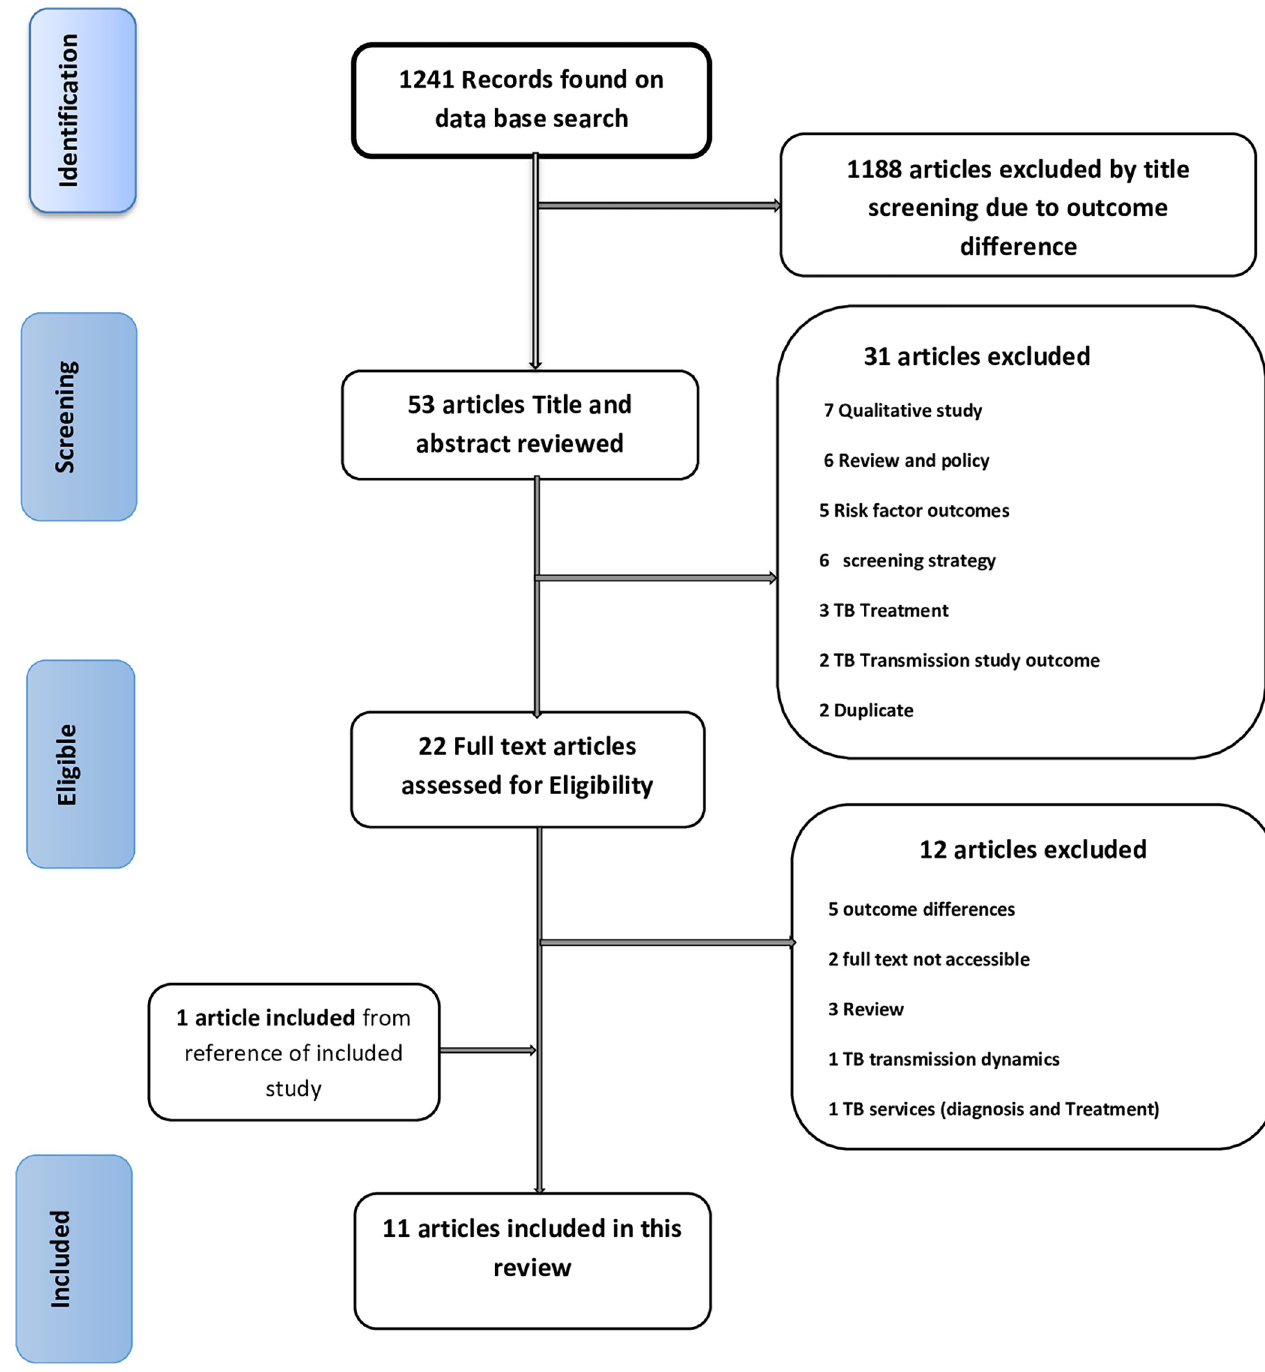
Fig 1. Selection process flow